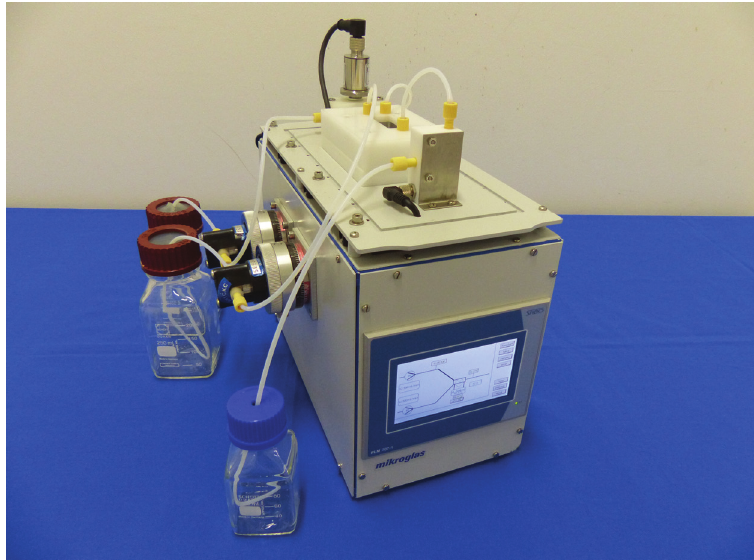
Figure 2 MikroSyn Initio for liquid/liquid